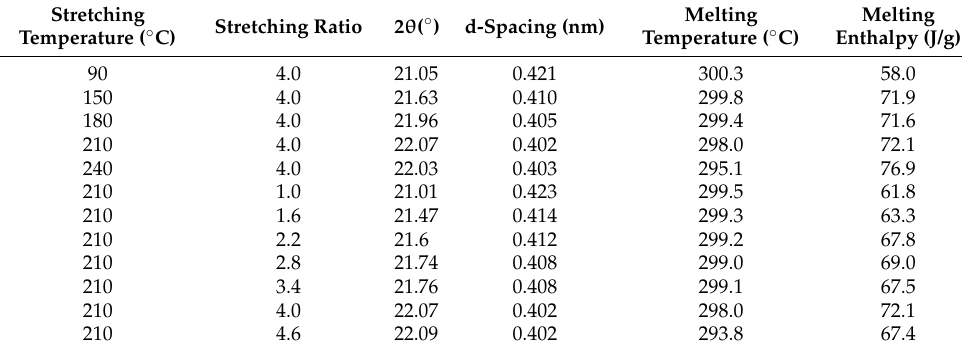
Figure 3. WAXD patterns of PA12T samples stretched at ( a ) different stretching temperatures; ( b ) different stretching ratios. Table 1. D-spacing and melting enthalpy of uniaxially stretched PA12T